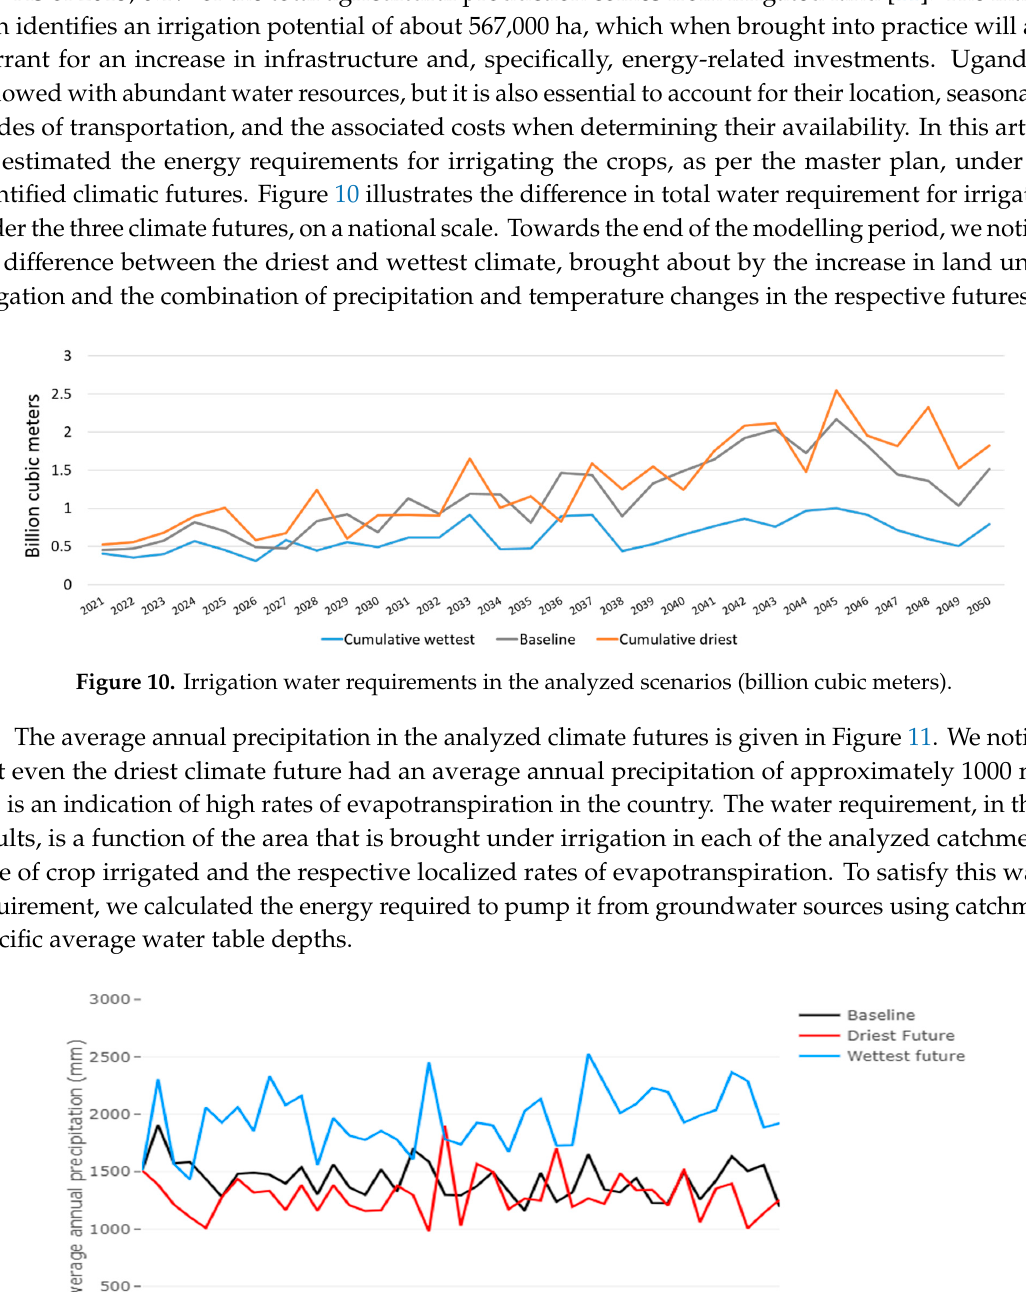
Figure 11. Annual precipitation in the analyzed climate futures (mm/year).